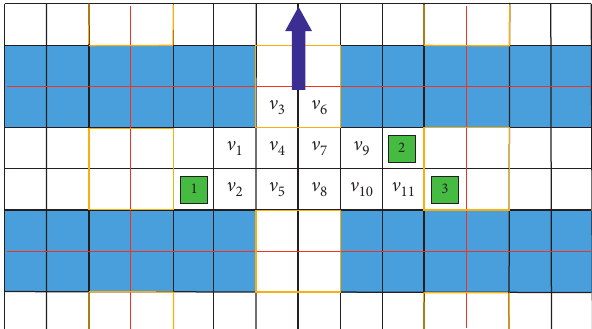
Figure 7: Illustration of the example of trying to plan path for three robots in the district. The original location of robots is shown in the figure. And the blue arrow indicates the next district where these three robots are heading to. v 1 ∼ v 11 represent different locations in the district and v 6 is the destination where robots are leaving from the current